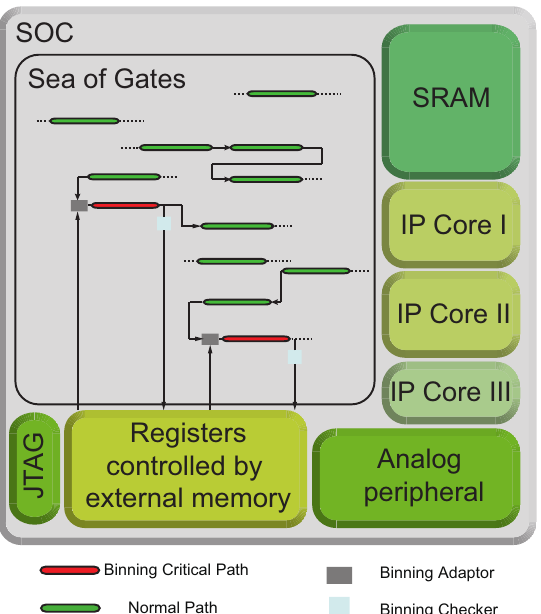
Figure 1. Overview of the proposed on-chip adaptive binning and F max yield optimization